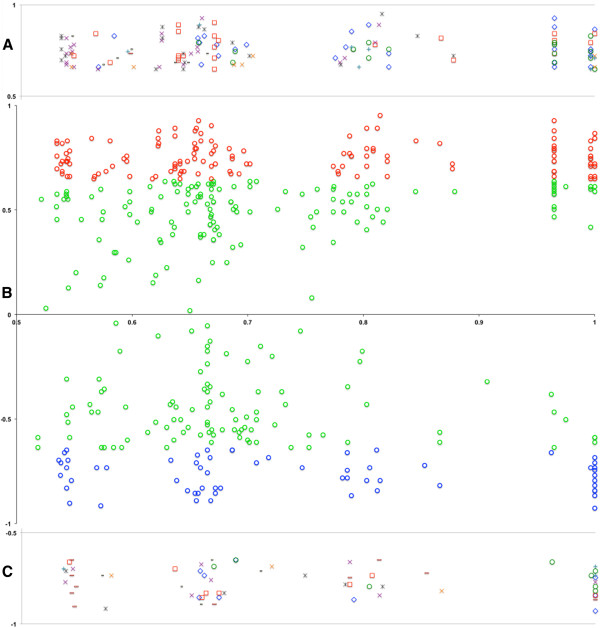
Pearson's correlation of miRNA-mRNA pairs vs. significant confidences of their interactions discovered by SA-BNs. A: Depiction of positive interactions from each miRNA. B: Pearson's correlation of miRNA-mRNA pairs vs. significant confidences of their interactions discovered by SA-BNs. The X-axis shows the confidence of interactions, ranging from 0 (the least confident) to 1 (the most confident), while only the statistical significant scale remains (P<0.05). The Y-axis shows the sample correlations of identified miRNA-mRNA pairs. The red and blue dots are miRNA-mRNA pairs, which are correlated at the significant level (P<0.05). It shows that the identified interactions are largely correlated, either negatively or positively, suggesting direct interactions and indirect interactions correspondingly. C: Depiction of negative interactions from each miRNA ◊miR137 □miR153 OmiR218 ×miR299-5p *miR376a XmiR122 +miR592 –miR584 -Others.